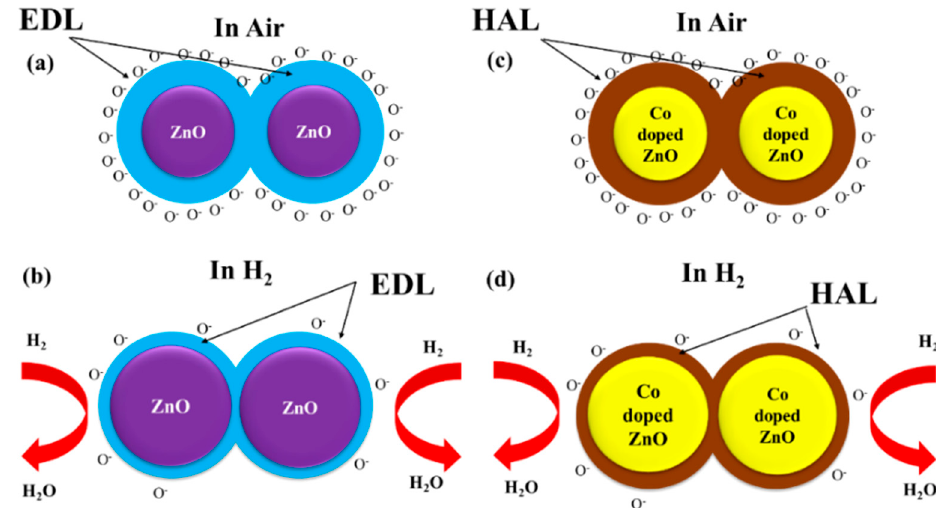
Scheme 1. Schematization of the H 2 sensing mechanism in pristine and Co-doped ZnO gas sensors.